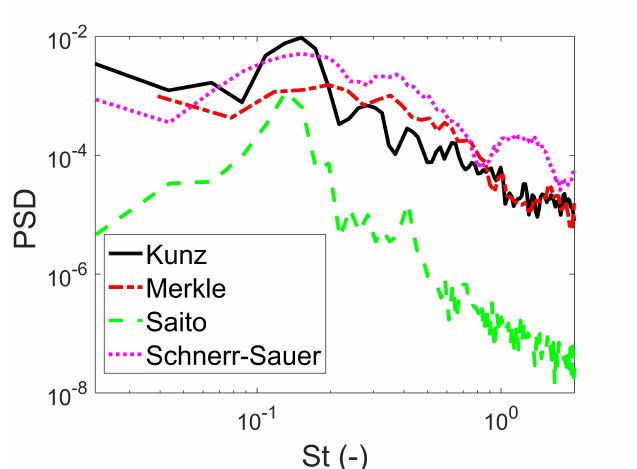
Figure 12. Lift coefficient, results obtained considering standard coefficients (Table 2).